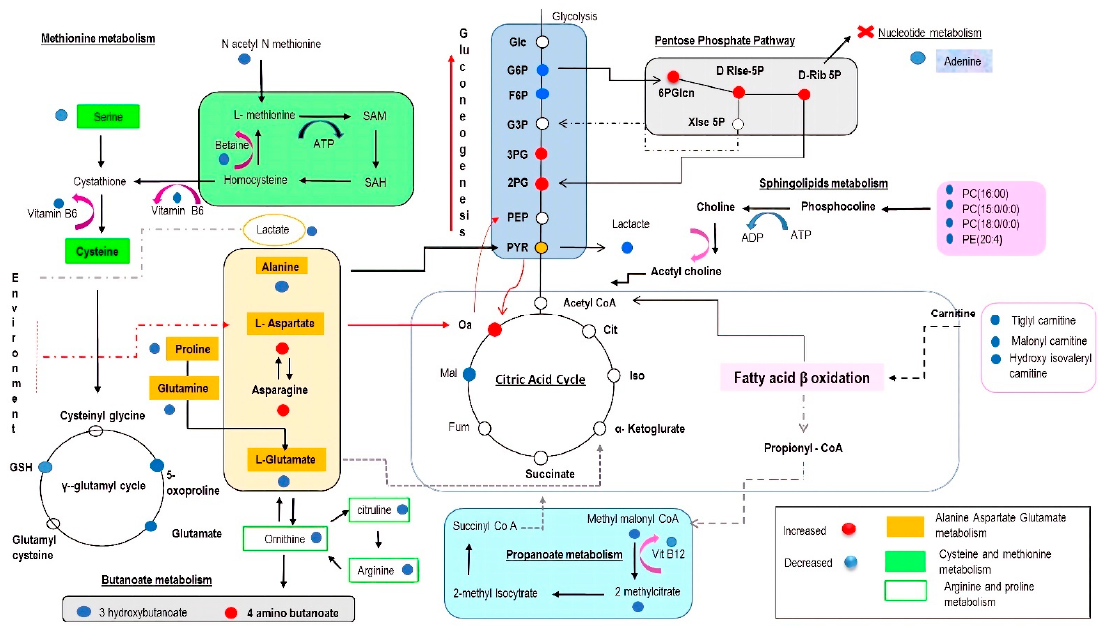
Figure 5. Schematic representation of significantly altered metabolites and metabolic pathways affected in CCC heart tissue vs. healthy donors. Diagram representing the level of metabolites in cardiac tissue from patients with CCC. Blue-colored spots represent decreased levels of metabolite. Red-colored spots represent an increased metabolite level in CCC while the white spots represent metabolites that did not show changes between the groups.